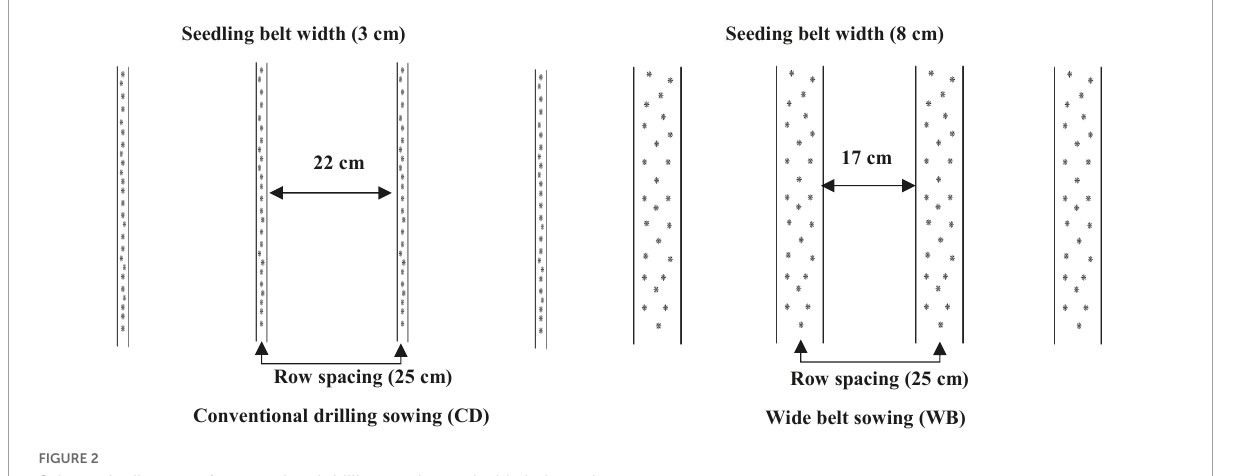
FIGURE2 Schematic diagram of conventional drilling sowing and wide belt sowing.